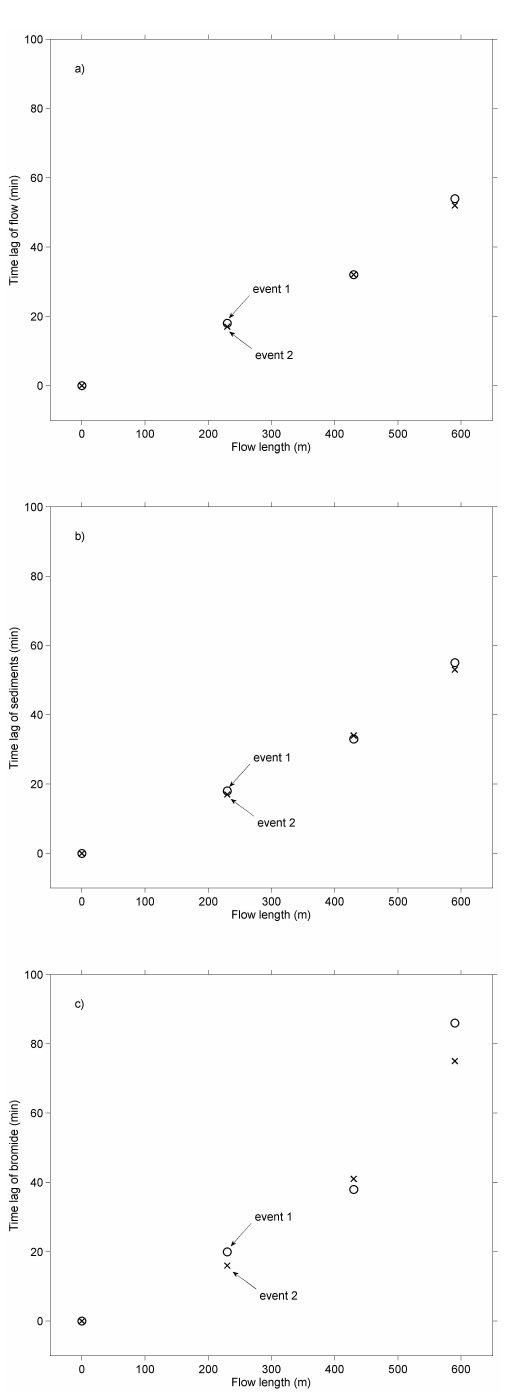
Fig. 9. Time lag of water (celerity) (a) , sediment (b) and bromide (velocity) (c) for the two flooding experiments (event 1 and event 2) estimated from the first appearance (first rise) of the